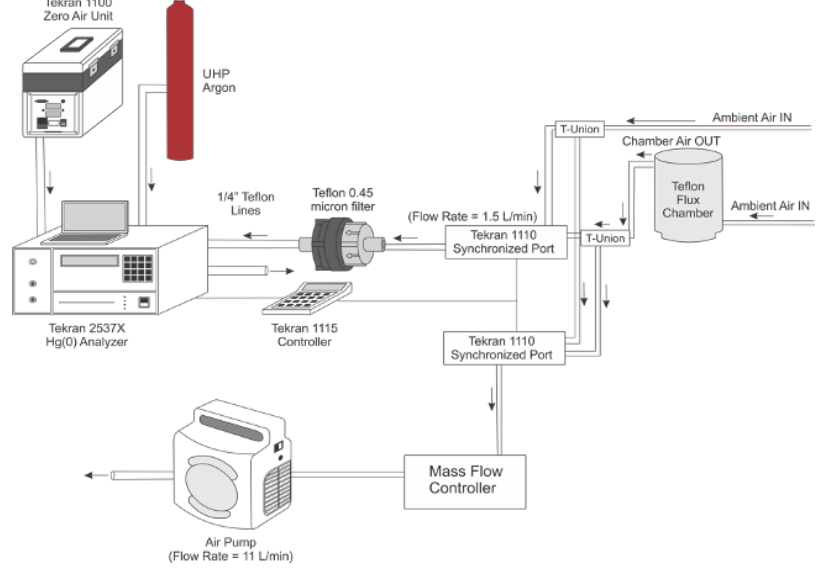
Figure 2. Diagram of the typical experimental setup for the operation of dynamic flux chamber system to measure the Hg emission fluxes over the vegetation used in both sites.